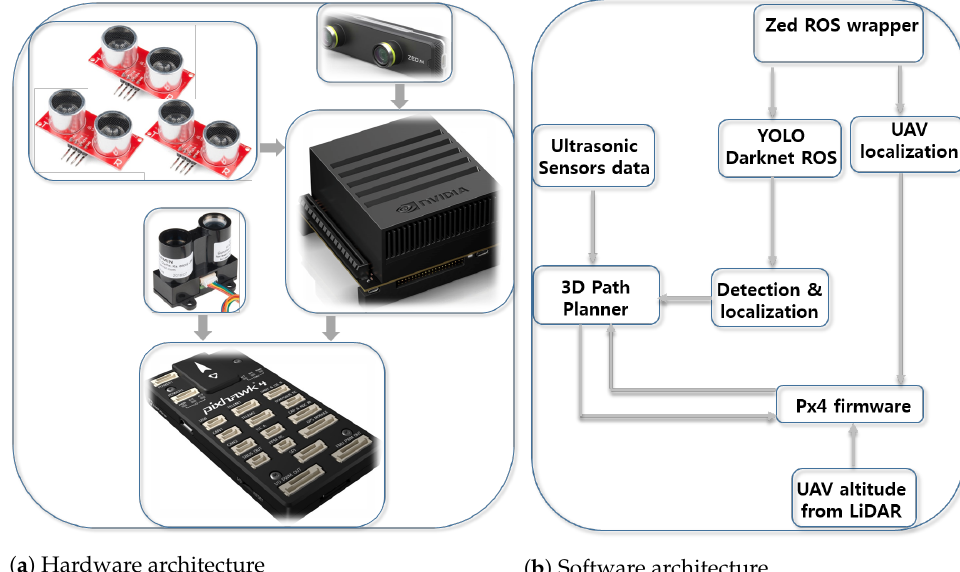
Figure 2. Architectures of hardware and